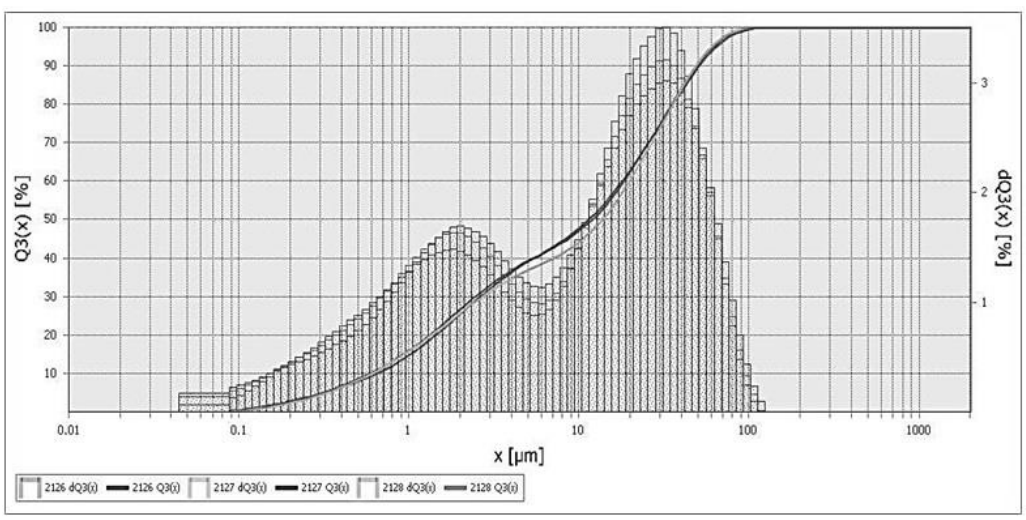
Figure 3. Fractional composition of ocher.